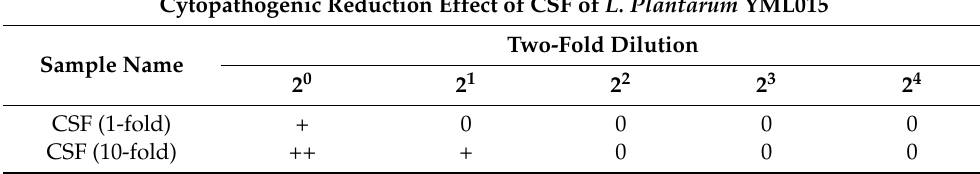
Table 4. Cytopathogenic reduction effect of CFS of L. plantarum YML015 against H1N1.